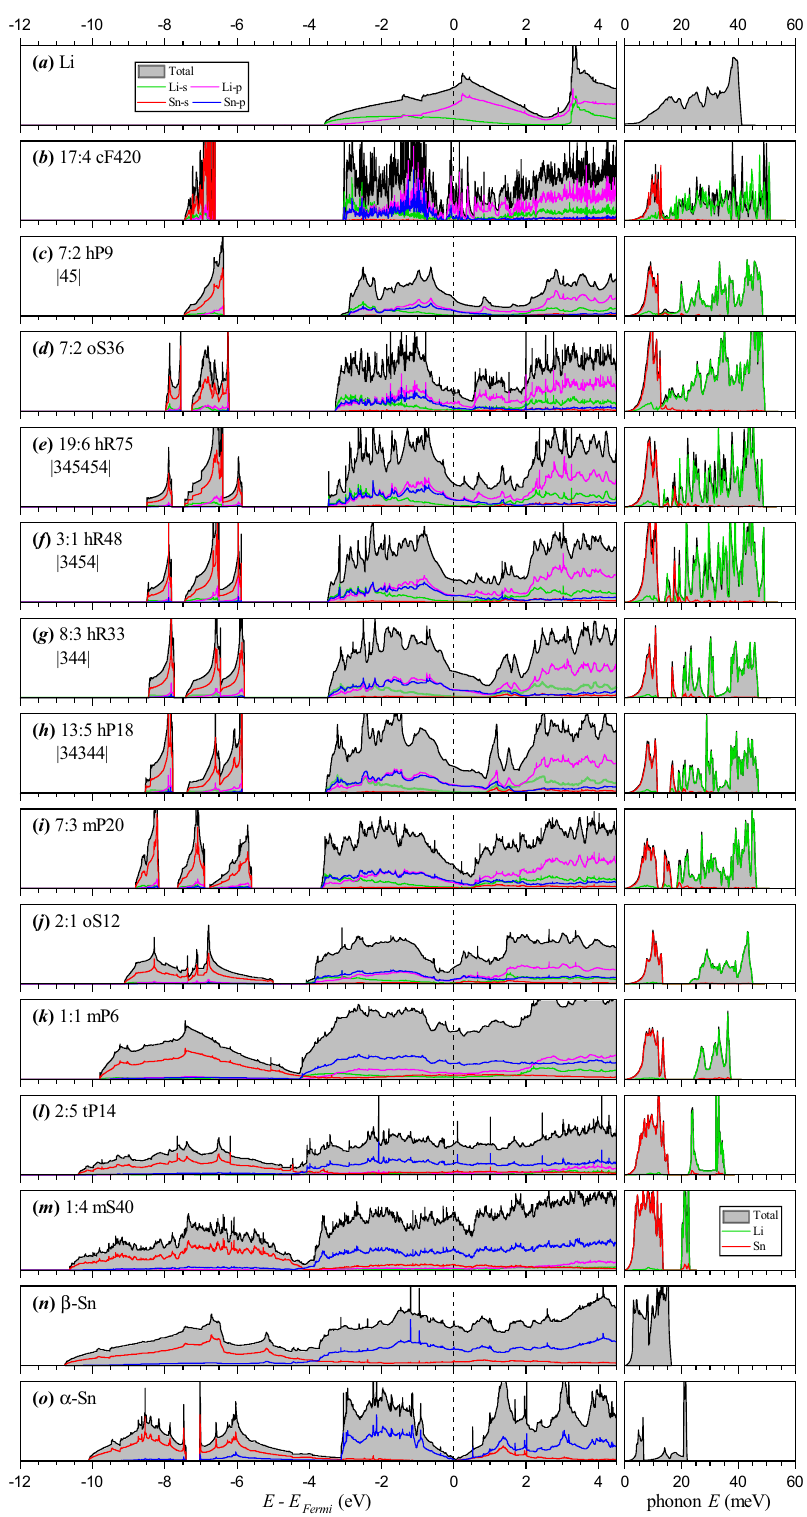
Fig. 8 Electron and phonon DOS calculated with the DFT for known and predicted ambient-pressure Li-Sn phases. The colored lines illustrate the DOS projected onto s and p orbitals for electrons (left panels) or onto Li and Sn atoms for phonons (right